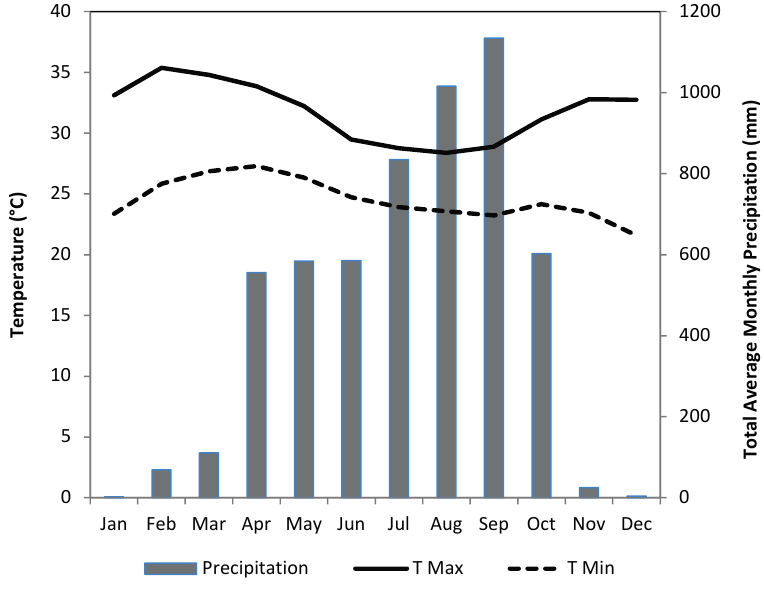
Figure 2. Average monthly precipitation, minimum temperature (T Min), and maximum temperature (T Max) for the study